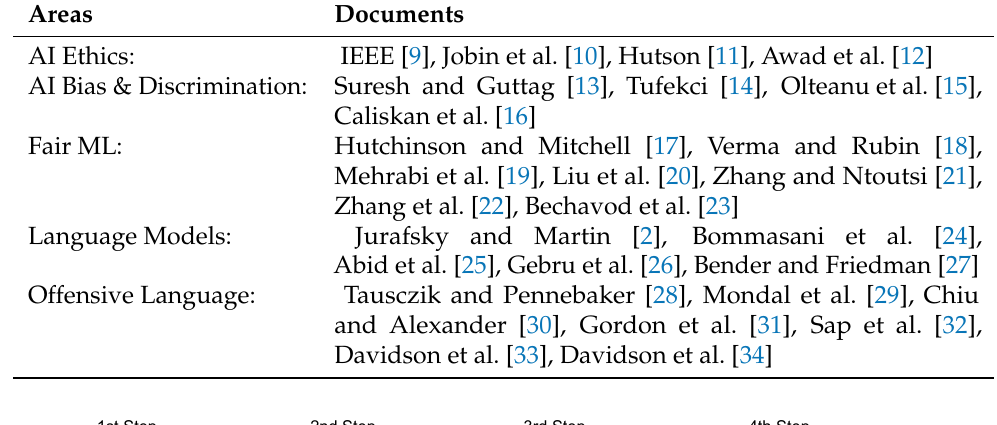
Table 1. Articles selected in the systematic mapping.